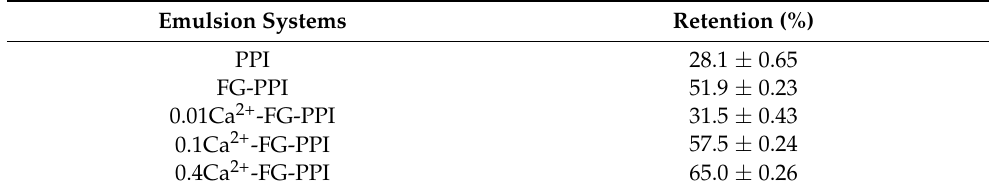
Table 2. Analysis of astaxanthin retention rate and color change in algae oil emulsion after